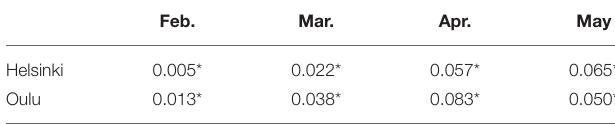
TABLE 1 | Kolmogorov-Smirnov distances. Feb.